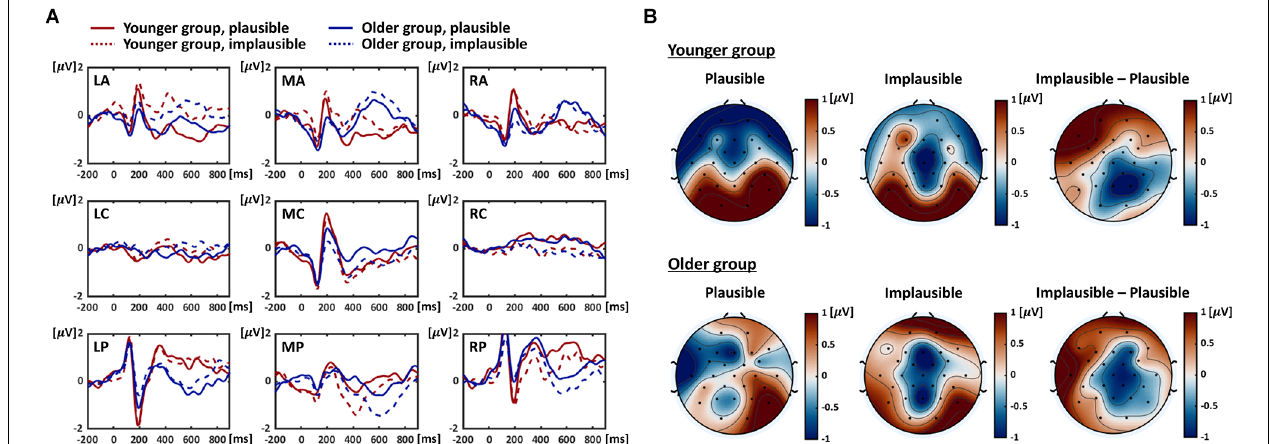
FIGURE 2 | Grand-averaged ERPs and N400 topographic patterns. (A) Grand-averaged ERPs according to plausibility conditions in two age groups. The figures show the averaged ERP signals obtained from nine channel groups. The red and blue lines represent the signals acquired in the younger and older groups, and the solid and dotted lines indicate the signals derived from the plausible and implausible condition respectively. LA, left anterior; LC, left central; LP, left posterior; MA, middle anterior; MC, middle central; MP, middle posterior; RA, right anterior; RC, right central; RP, right posterior. (B) N400 topographic patterns in two age groups. The figures present the averaged N400 topographic patterns derived based on individual time windows for the N400. In the sub-figures for each group, the left and middle columns show the results for each plausibility condition, and the right columns exhibit the differences between them (implausible–plausible). The color code indicates the scalp voltage on each